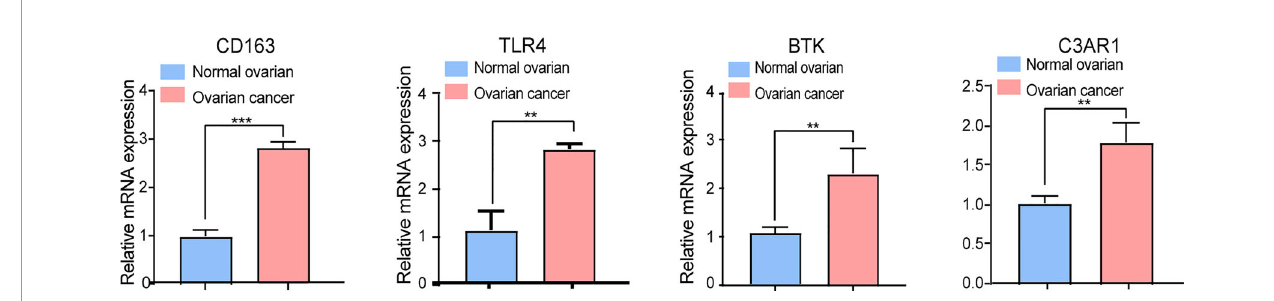
FIGURE 7 | RT-qPCR analysis of four key IRGs in the ovarian cancer tissues and normal ovarian tissues. All experiments were performed in triplicate. ** p - value t- test < 0.01; *** p - value t-test < 0.001.